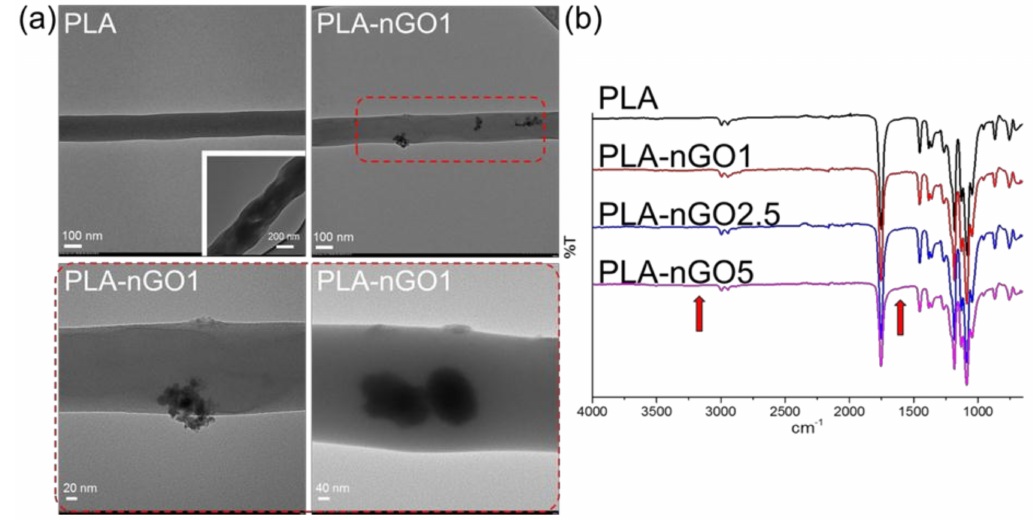
Figure 1. ( a ) TEM images of poly(lactic acid) (PLA) and PLA-nGO1 fibers; ( b ) Fourier transform infrared (FTIR) spectra of PLA, PLA-nGO1, PLA-nGO2.5, and PLA-nGO5